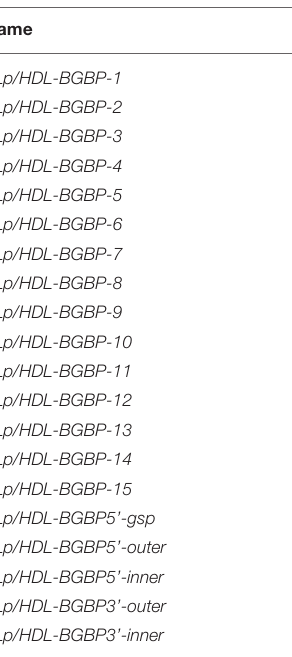
TABLE 1 | Primers used for dLp/HDL-BGBP cloning in the present